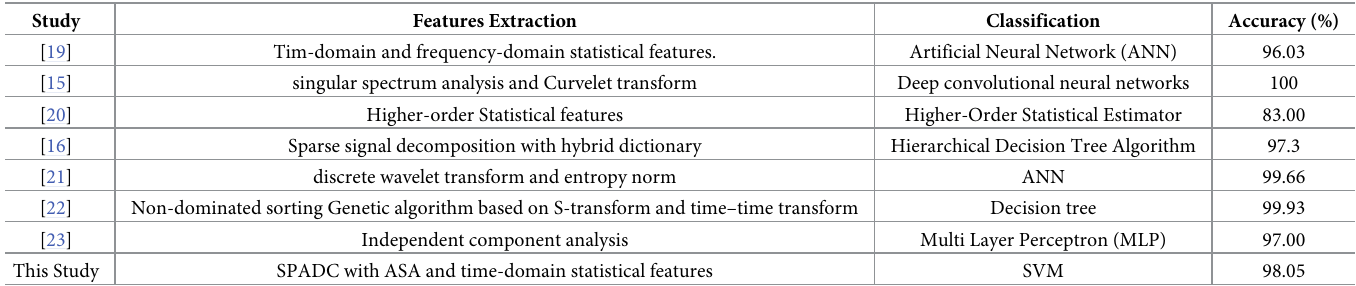
Table 6. Comparison with state-of-the-art methods.